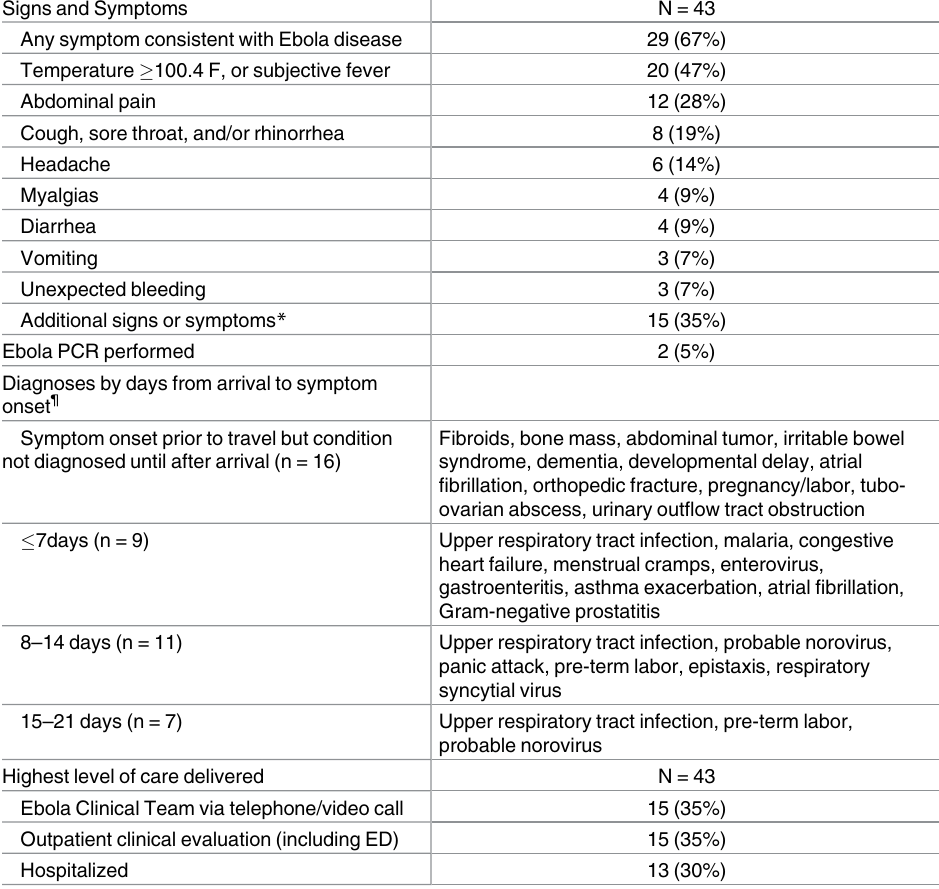
Table 2. Clinical symptoms, evaluation, and diagnosis of monitored travelersrequiring Clinical Ebola Team—Minnesota, October 21, 2014–May 15, 2015. Signs and Symptoms N = 43 Any symptom consistent with Ebola disease 29 (67%) Temperature (cid:21) 100.4 F, or subjective